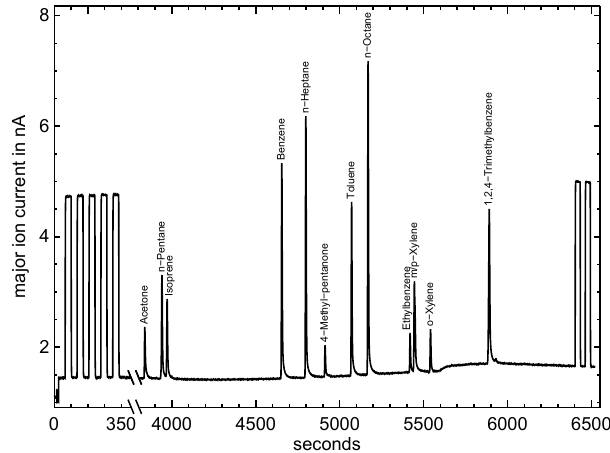
Figure 2. Example of an IRMS chromatogram (major signal) of the VOC test mixture. Working reference gas peaks are added at the beginning (5 peaks) and the end (2 peaks) of every